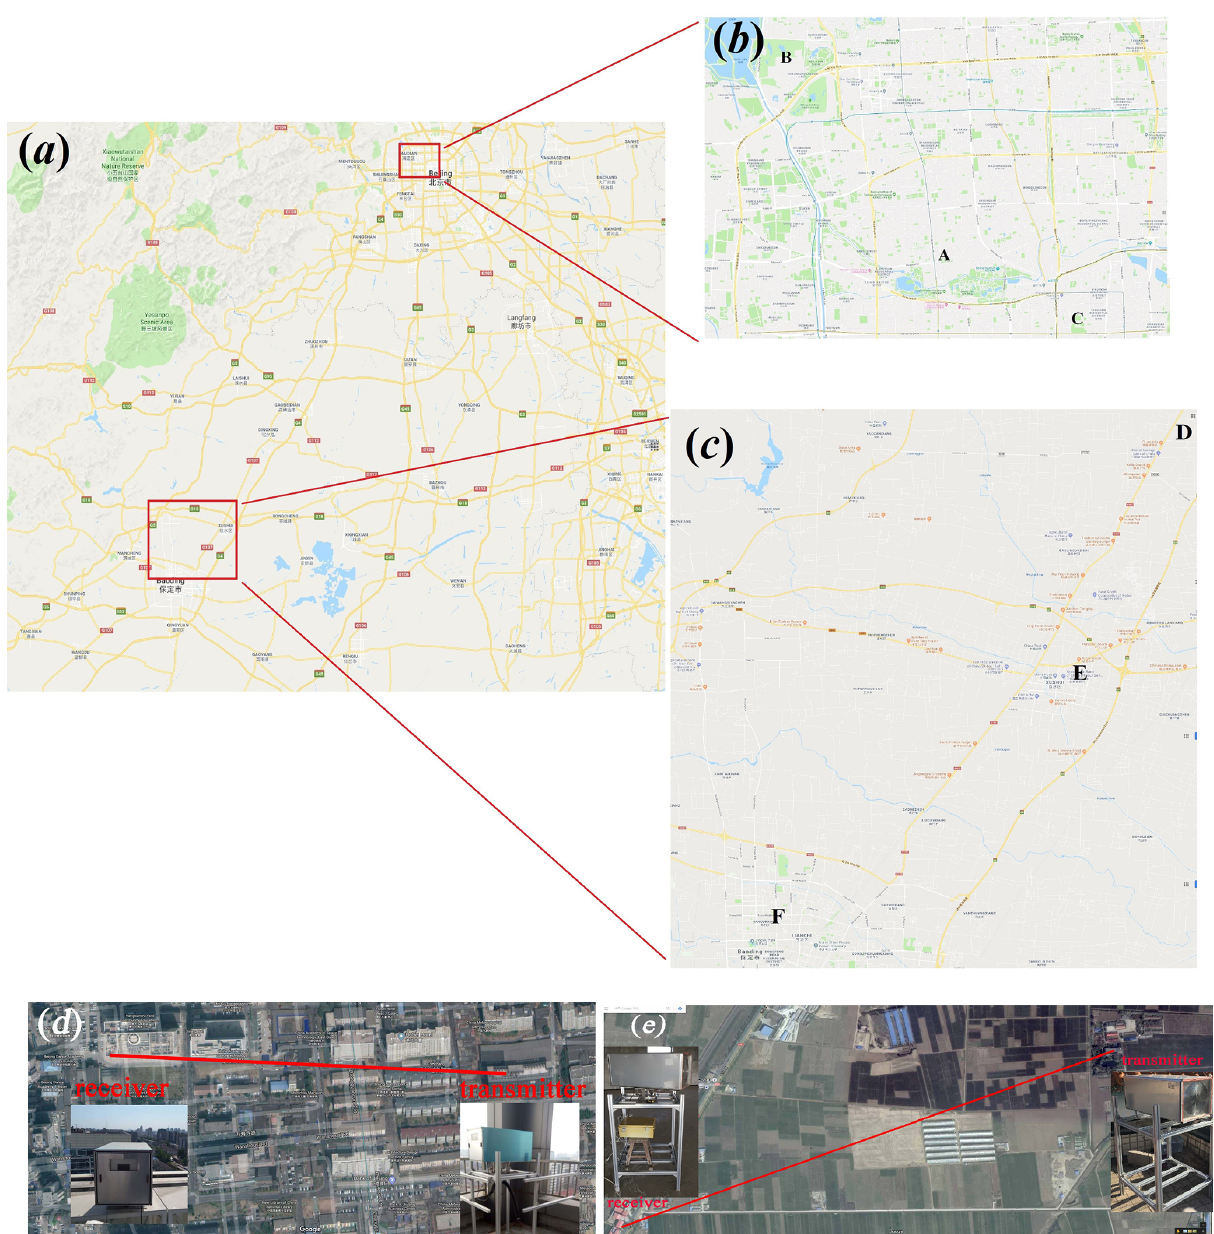
Figure 1. Photographs of the measurement site. (a) Map of the experiment area in the Beijing urban area and suburban area and (b) expanded view of the Beijing experiment area, which is marked as the rectangle in (a) . (c) Expanded view of the Baoding experiment area, which is marked as the rectangle in (a) . (d) Satellite image of the CAMS site and (e) the satellite image of the GC site. Panels (a) , (b) , (c) , and (d)